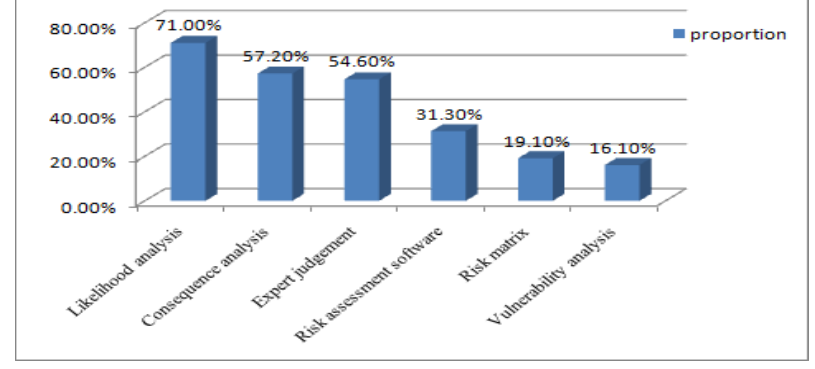
Figure 2. The proportion of respondents’ familiarity with risk assessment tools (%).